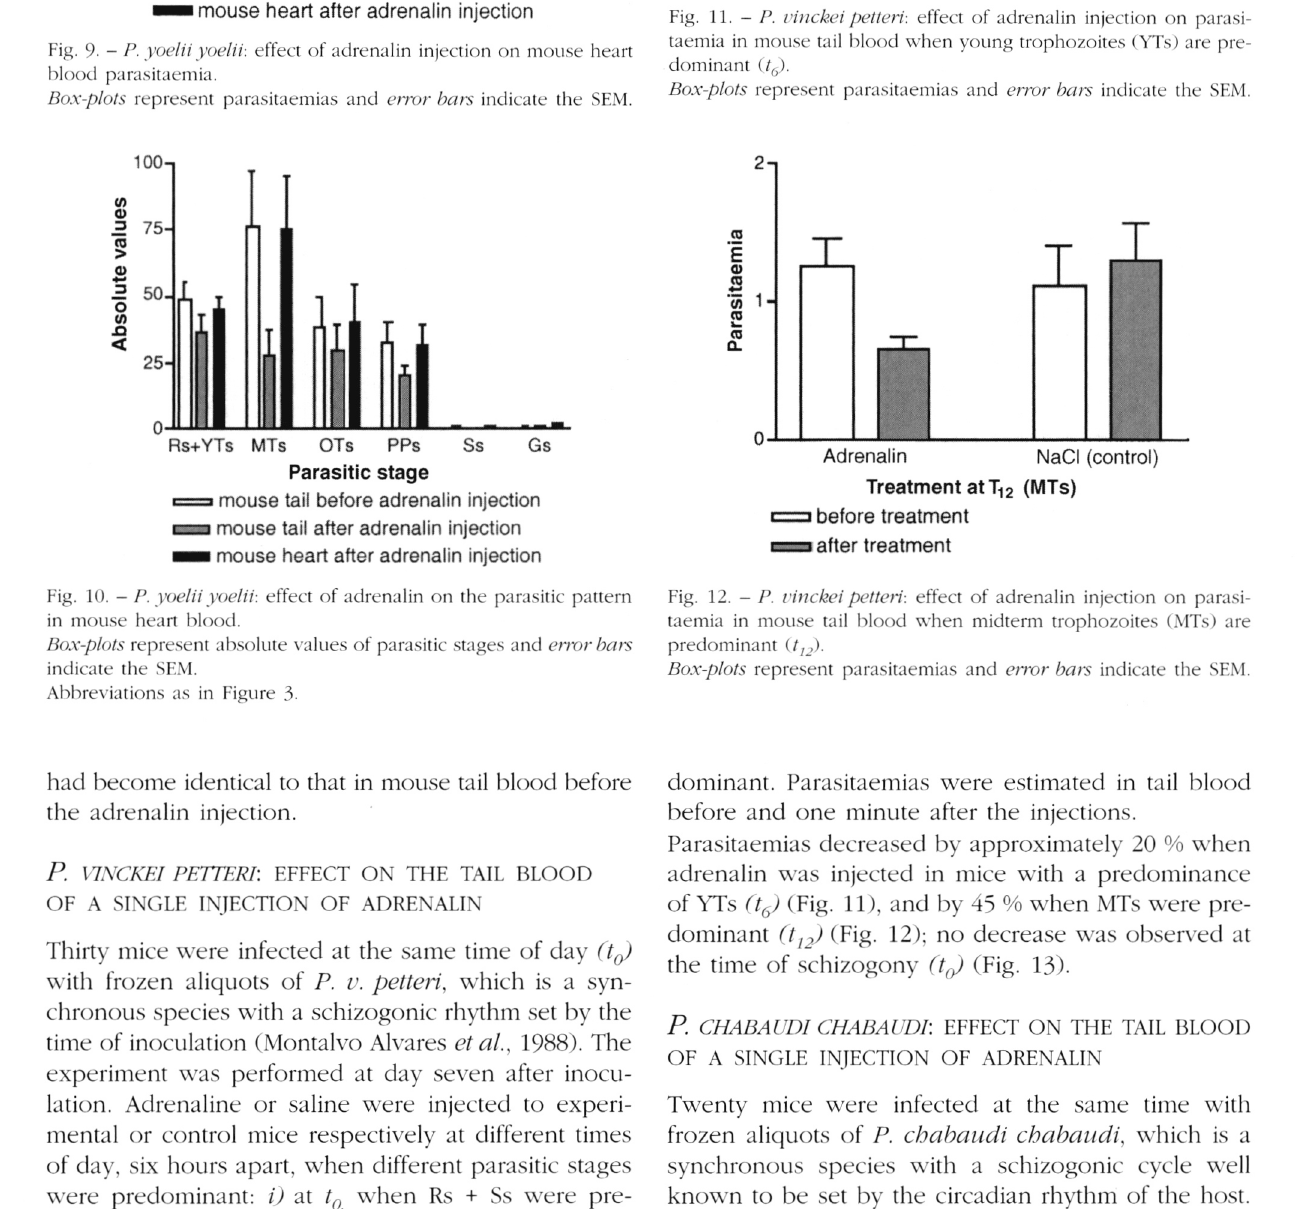
Fig. 11. - P. vinckei petteri: effect of adrenalin injection on parasi­ taemia in mouse tail blood when young trophozoites (YTs) are pre­ dominant (t6). Box-plots represent parasitaemias and error bars indicate the SEM.